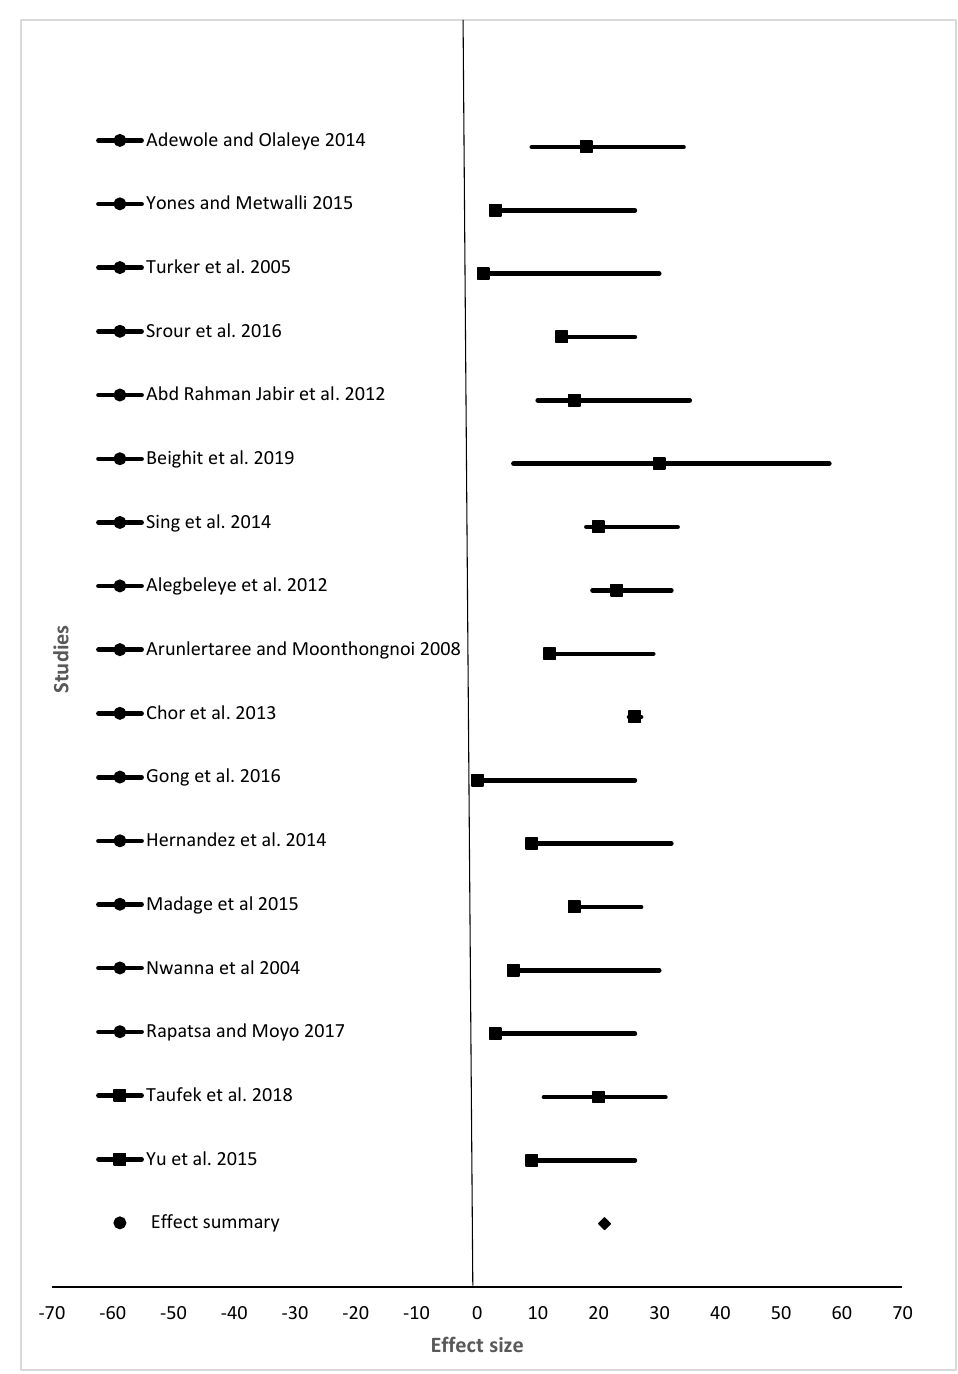
Figure 3. The effect size of specific growth rate (%) of fish from different studies fed different animal protein sources compared to fishmeal as a protein source.